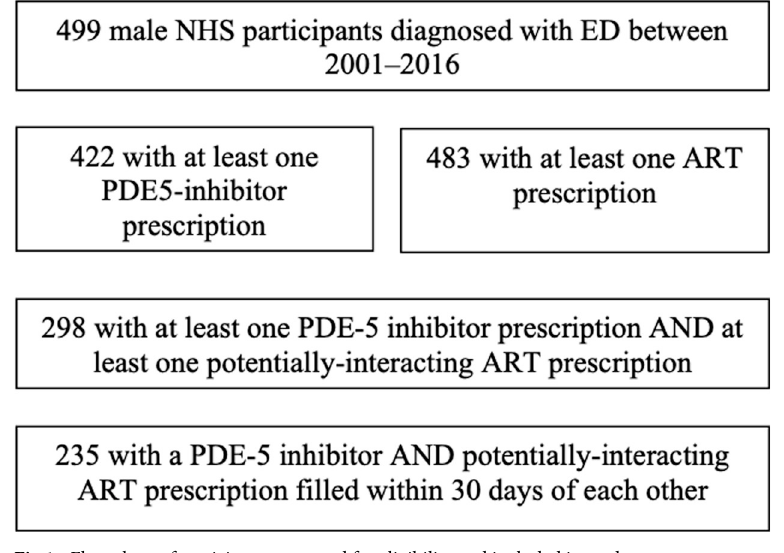
Fig 1. Flow chart of participants screened for eligibility and included in